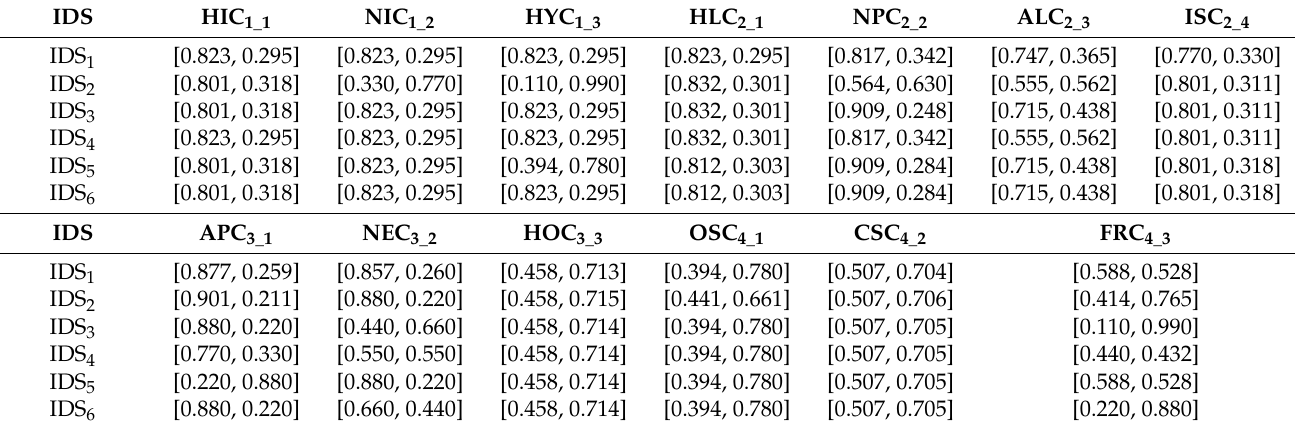
Table 13. The normalized evaluation matrix of the IDSs. Table 4. Combined evaluation matrix for alternatives in terms of the criteria based on q-ROFN.